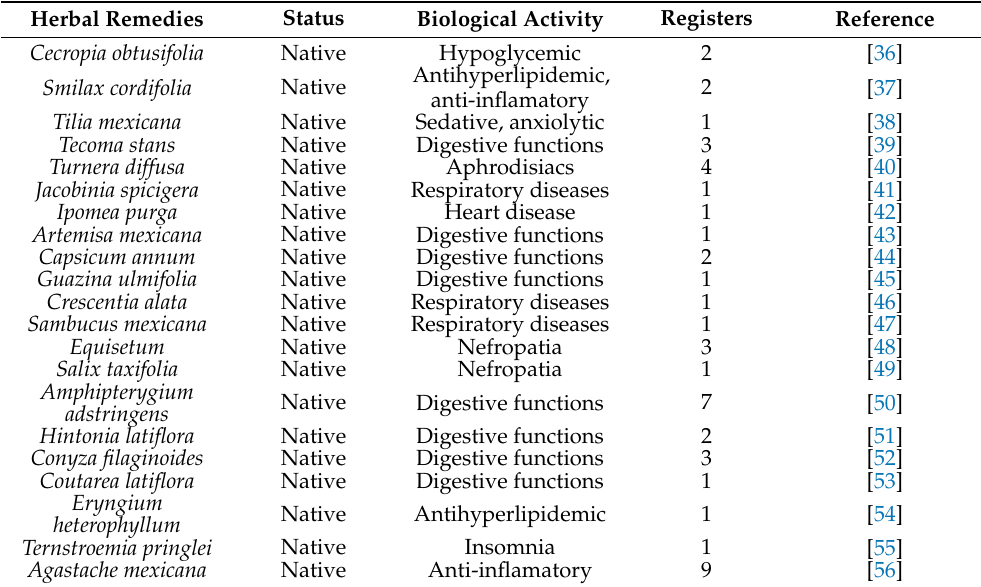
Table 3. Native plants used in herbal remedies with mainly biological activity and number of